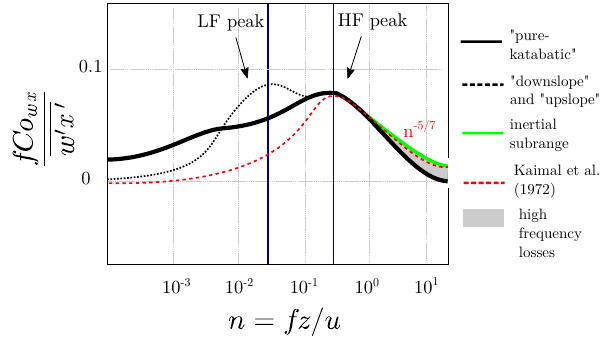
Figure 2. Cospectra of w with x = θ and of w with x = q measured in the surface layer of Zongo Glacier during the 2007 field cam- paign with one of the eddy-covariance systems (adapted from Litt et al., 2015). Cospectra were calculated over 1h runs and then av- eraged over each wind-regime subset. Mean cospectra for the “up- slope” and “downslope” subsets (dotted black line) and the low- wind-speed “pure-katabatic” subset (solid black line) are presented with the inertial subrange slope (solid green curve) and the refer- ence Kaimal curve (Kaimal et al., 1972) (dashed red curve) for com- parison. The peaks used to calculate the integral length scale of the Mann and Lenschow (1994) method are identified by the vertical blue lines; LF and HF stand for high and low frequency, respec- tively. The high-frequency losses assessed in Sect. 4.1.2 are shaded in